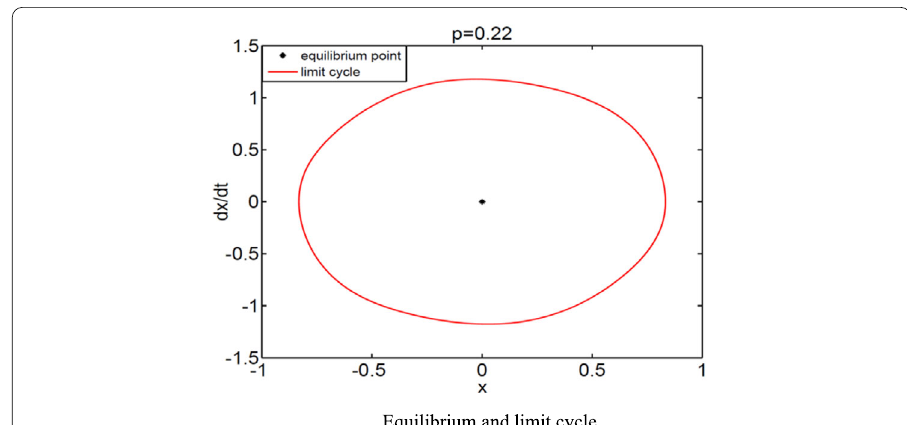
Figure 2 Phase diagram of the deterministic system (at p = 0.22)